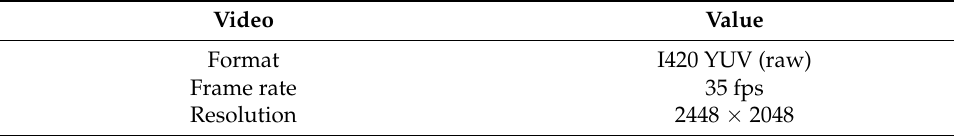
Table 1. Detailed specification for the test videos.